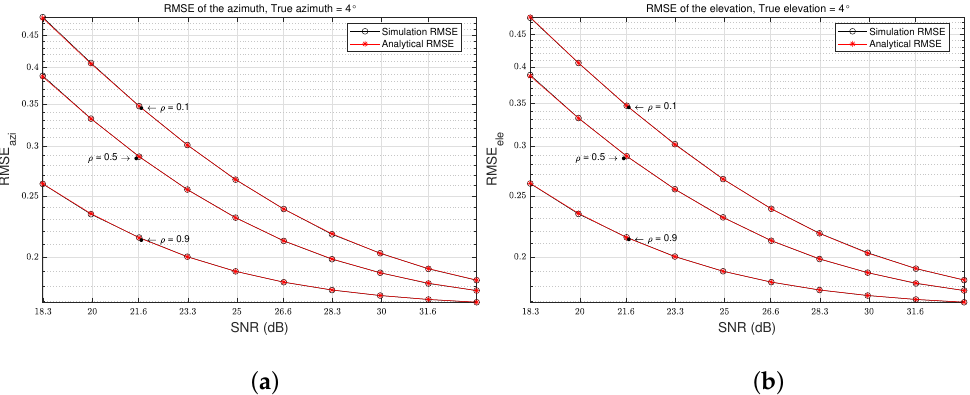
Figure 6. RMSE when the target’s azimuth and elevation are 4 ◦ . ( a ) RMSE of ˆ θ azi . ( b ) RMSE of ˆ θ ele .